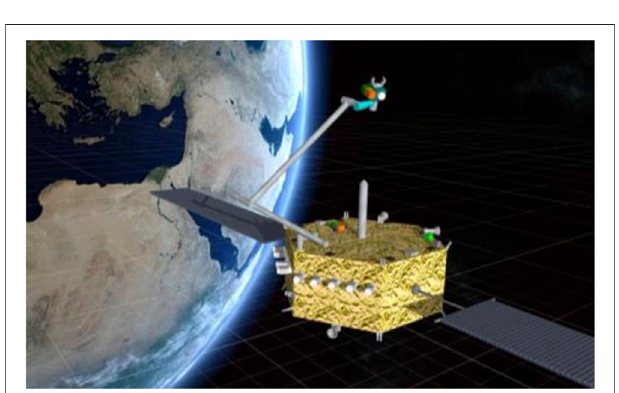
FIGURE 11 | The EROSS Concept includes a free- fl ying spacecraft equipped with a 7-DoF manipulator (EROSS EU Horizon 2020).